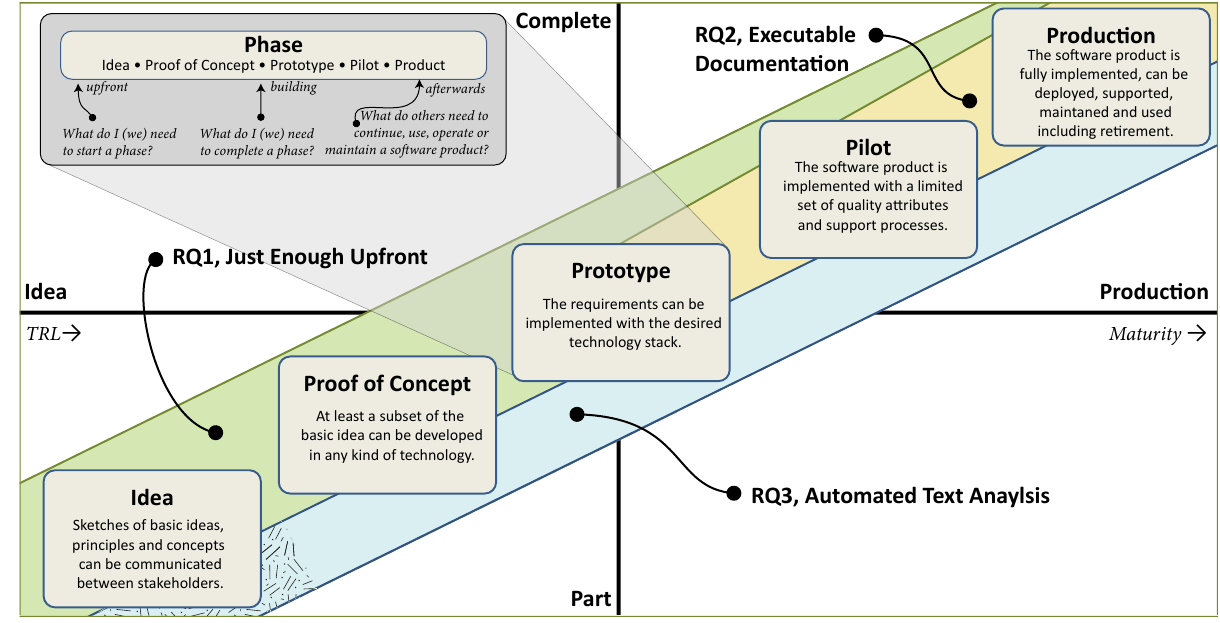
Figure 8. Relation between research questions, maturity, and completeness of the software product for each phase from Idea to